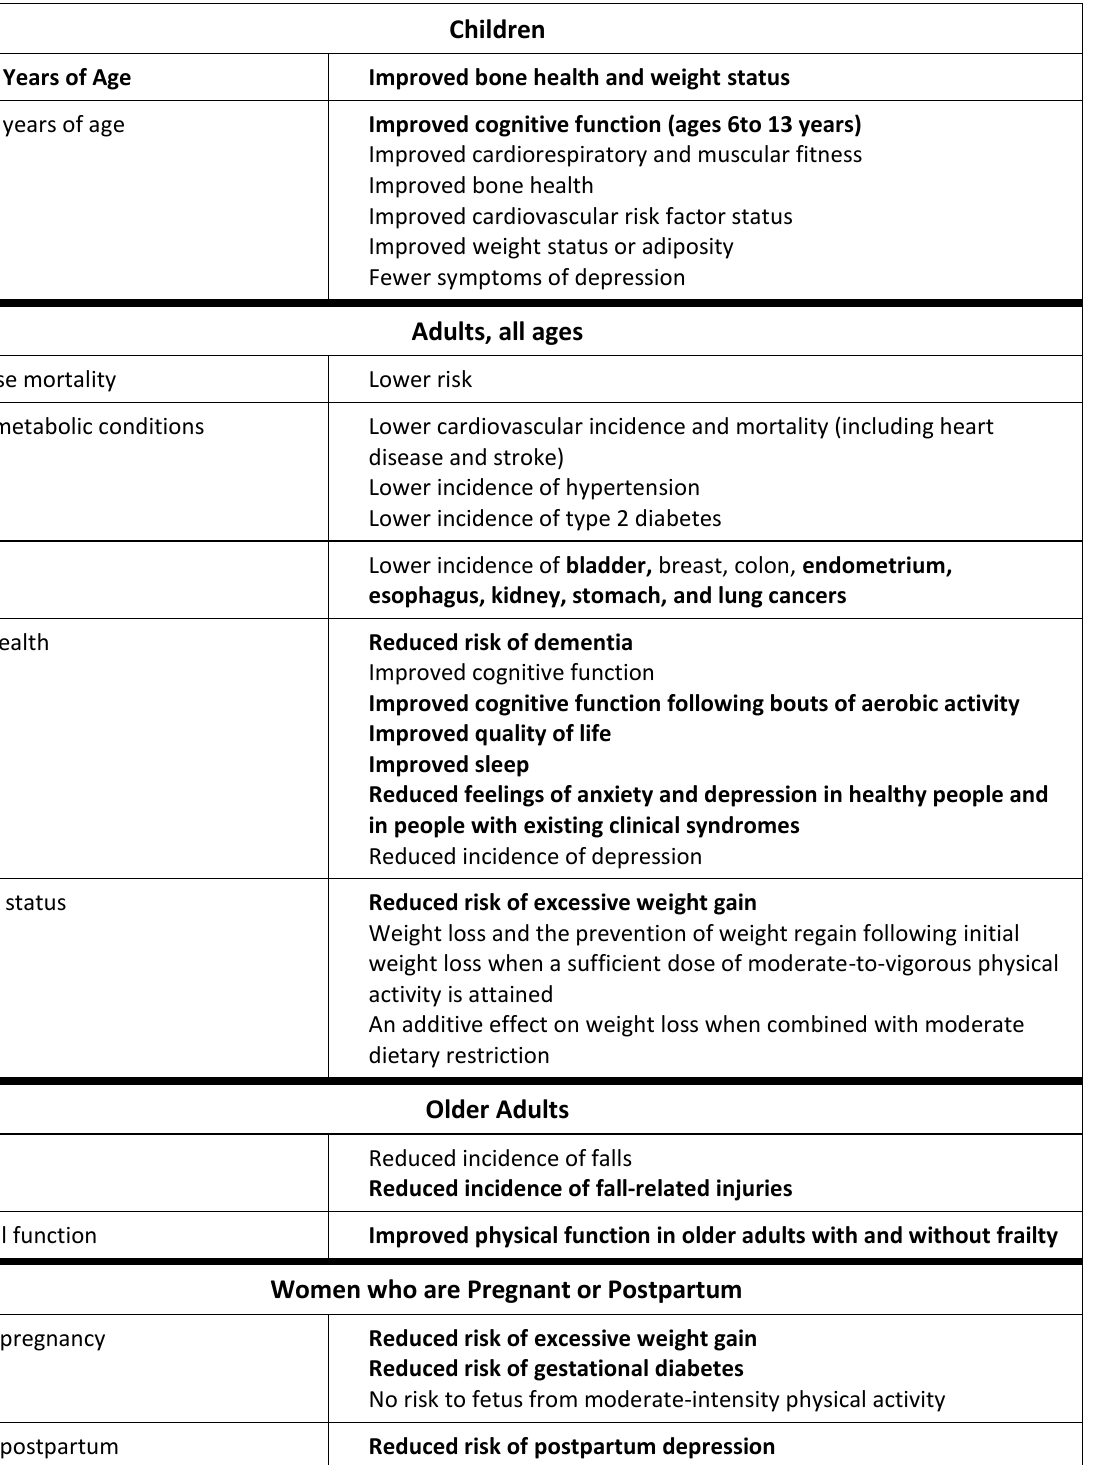
Table D-1. Physical Activity-Related Health Benefits for the General Population and Selected Populations Documented by the 2018 Physical Activity Guidelines Advisory